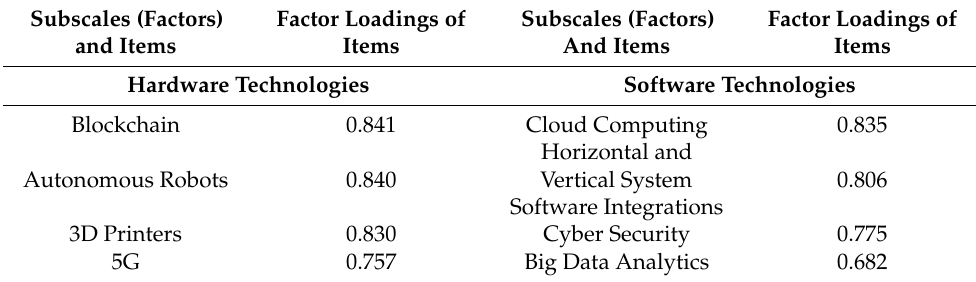
Table 3. Factor Loadings for Pilot Test.